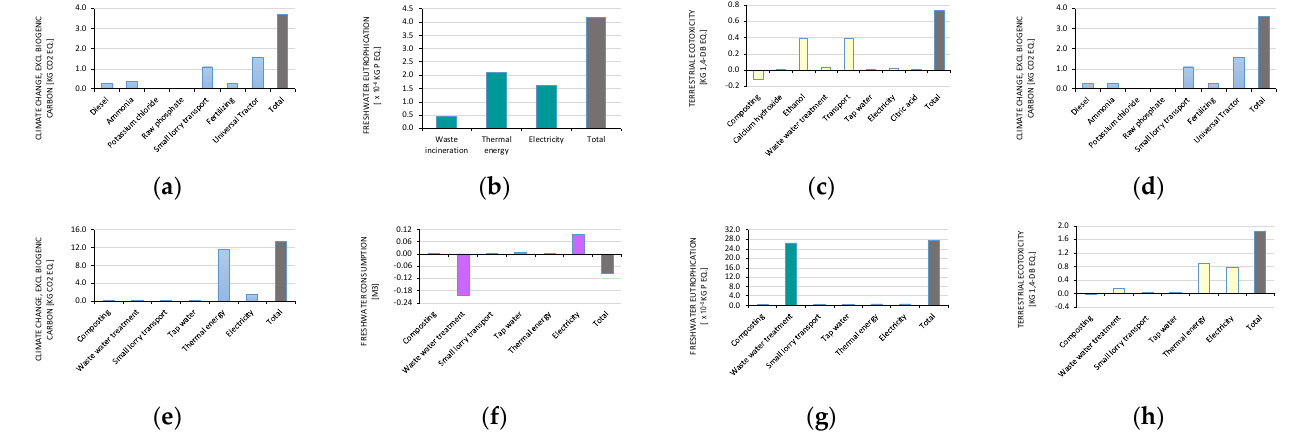
Figure 3. Representative impact categories for the four examined systems: ( a ) System A: cultivation—climate change; ( b ) System A: post-harvesting—freshwater eutrophication; ( c ) System A: stevia recovery—ecotoxicity; ( d ) System B: cultivation—climate change; ( e ) System C: stevia recovery—climate change; ( f ) System C: stevia recovery—freshwater consumption; ( g ) System C: stevia recovery—freshwater eutrophication; and ( h ) System C: stevia recovery—ecotoxicity. Table 1. Endpoint